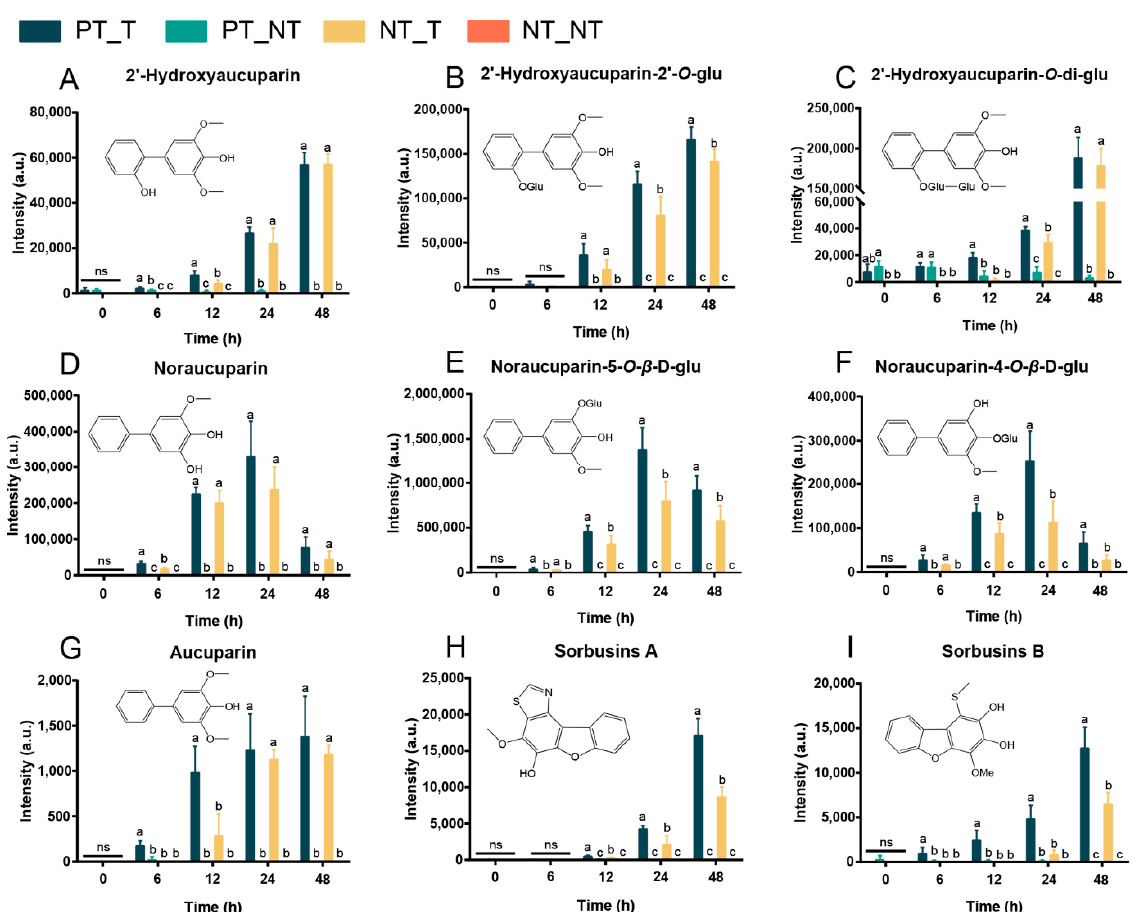
Figure 4. Contents of biphenyls in SPSCs in response to YE. ( A ) 2 ′ -hydroxyaucuparin, ( B ) 2 ′ -hydroxyaucuparin-2 ′ - O -glu, ( C ) 2 ′ -hydroxyaucuparin- O -di-glu, ( D ) noraucuparin, ( E ) noraucuparin-5- O - β -D-glu, ( F ) noraucuparin-4- O - β -D-glu, ( G ) aucuparin, ( H ) sorbusins A, and ( I ) sorbusins B. Different lowercase letters above columns indicate statistical differences at p < 0.05 by one-way ANOVA ( n = 4). ns, not significant.